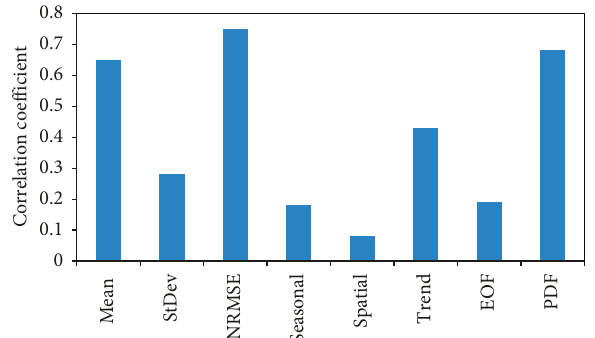
Figure 14: Correlations between single criterion and overall ranking